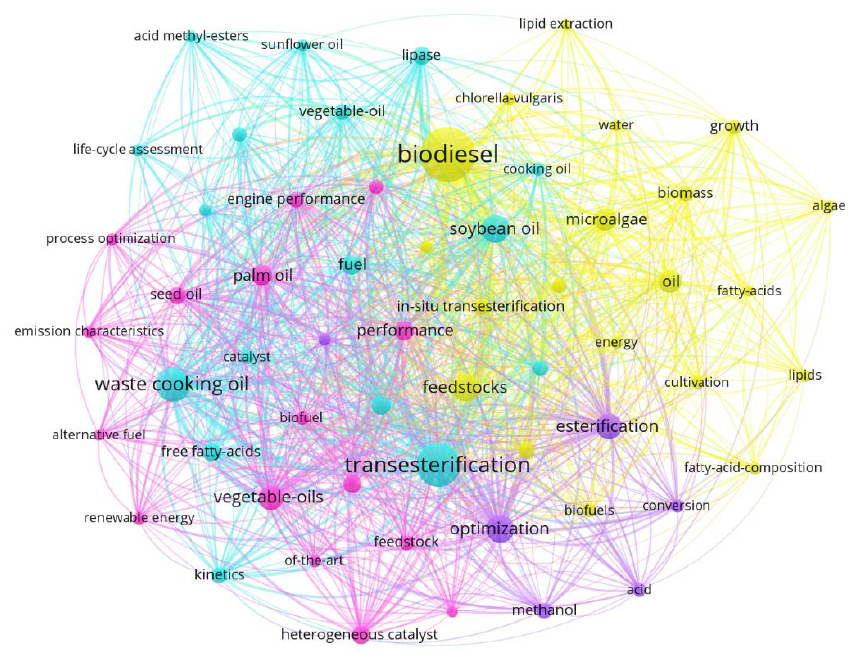
Figure 13. Visualization map of the co-citation network of keywords in the research related to raw materials for biodiesel production.